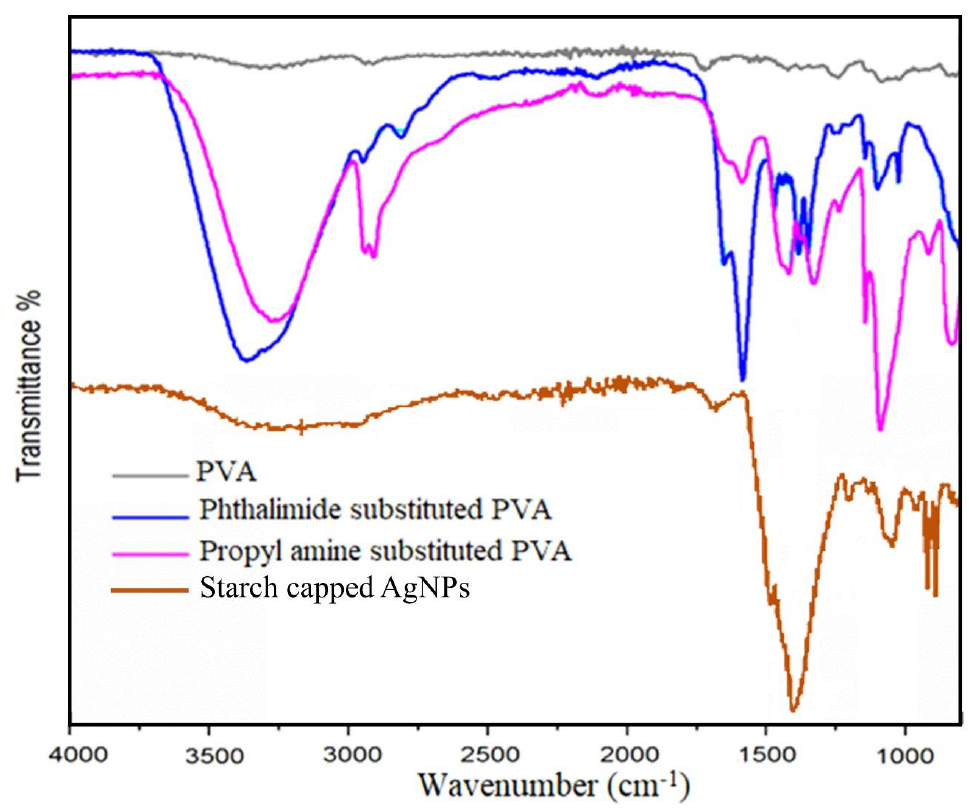
Figure 2. FTIR Spectra of PVA, phthalimide-substituted PVA, propylamine-substituted PVA and starch-capped Ag–NPs.